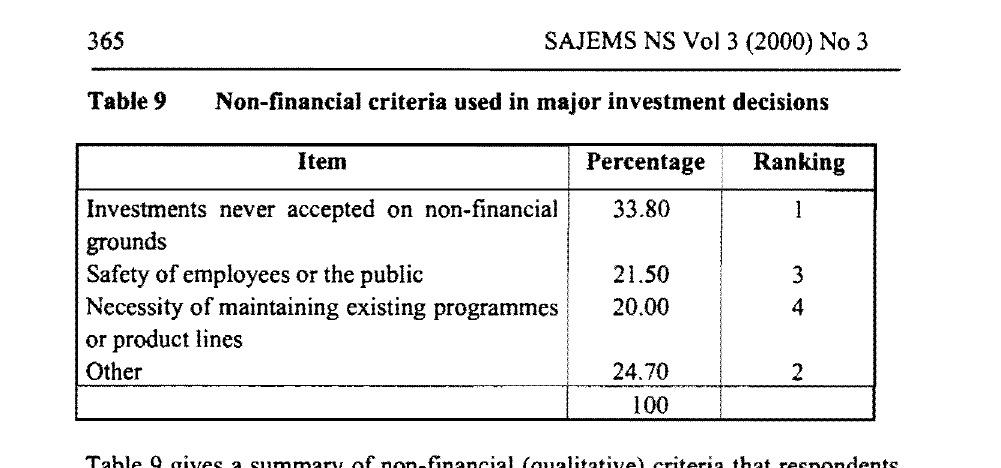
Non-financial criteria used in major investment